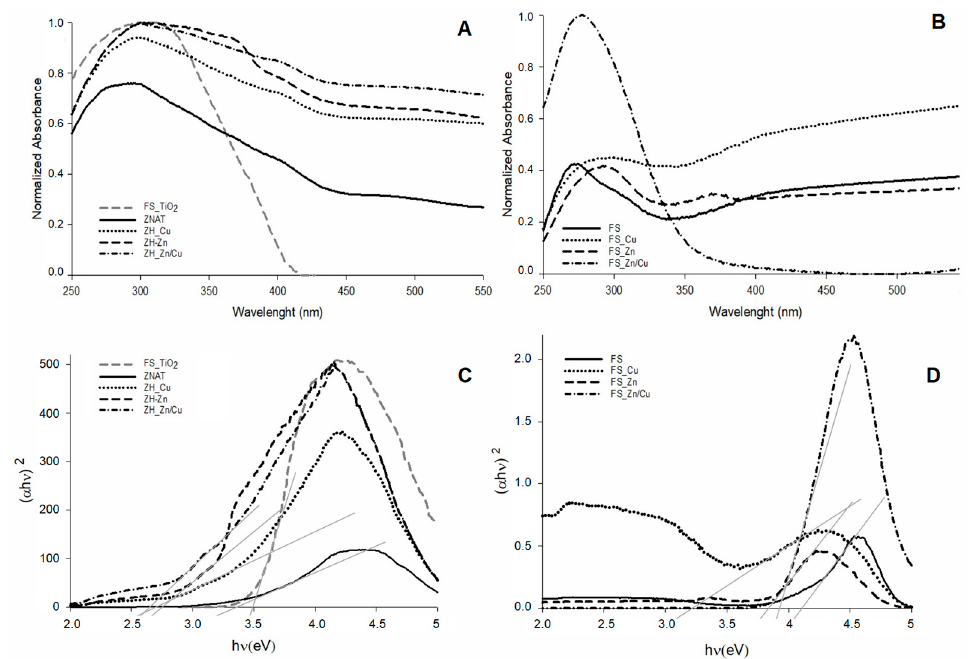
Figure 4. UV ‐ visible absorbance spectra (upper part) and Tauc plots (bottom part) of parent sup ‐ ports and prepared single and double metal oxide catalysts supported on modified natural zeolite ( A , C ), and fumed silica ( B , D ). Additionally, TiO 2 ( A , C ) is included as a benchmarked photo ‐